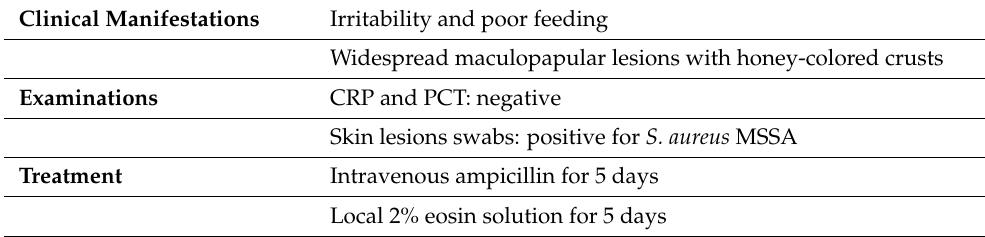
Table 1. Summary of case 1 with Staphylococcal bullous